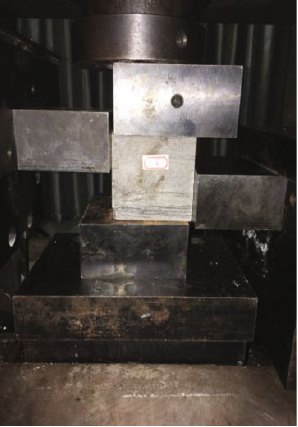
Figure 5: Shear resistance